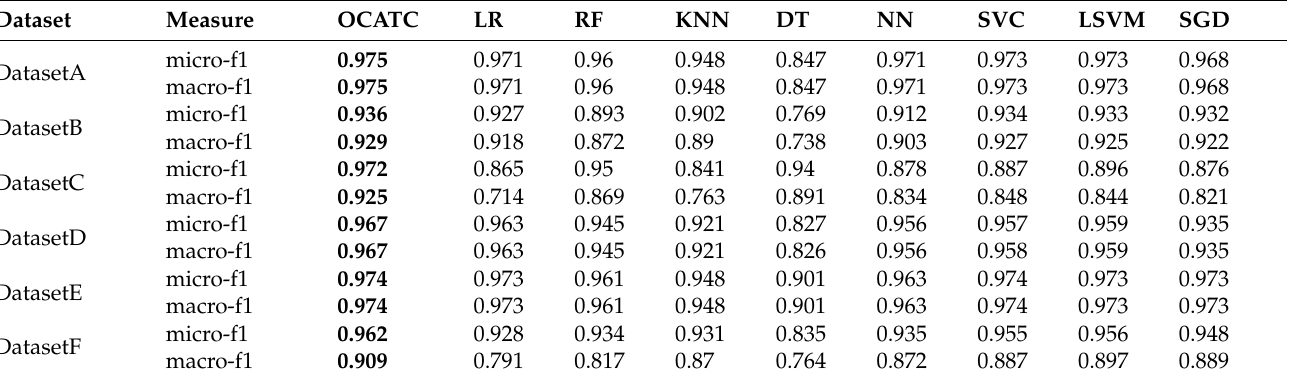
Table 5. Comparison of OCATC (optimal configurations) and single